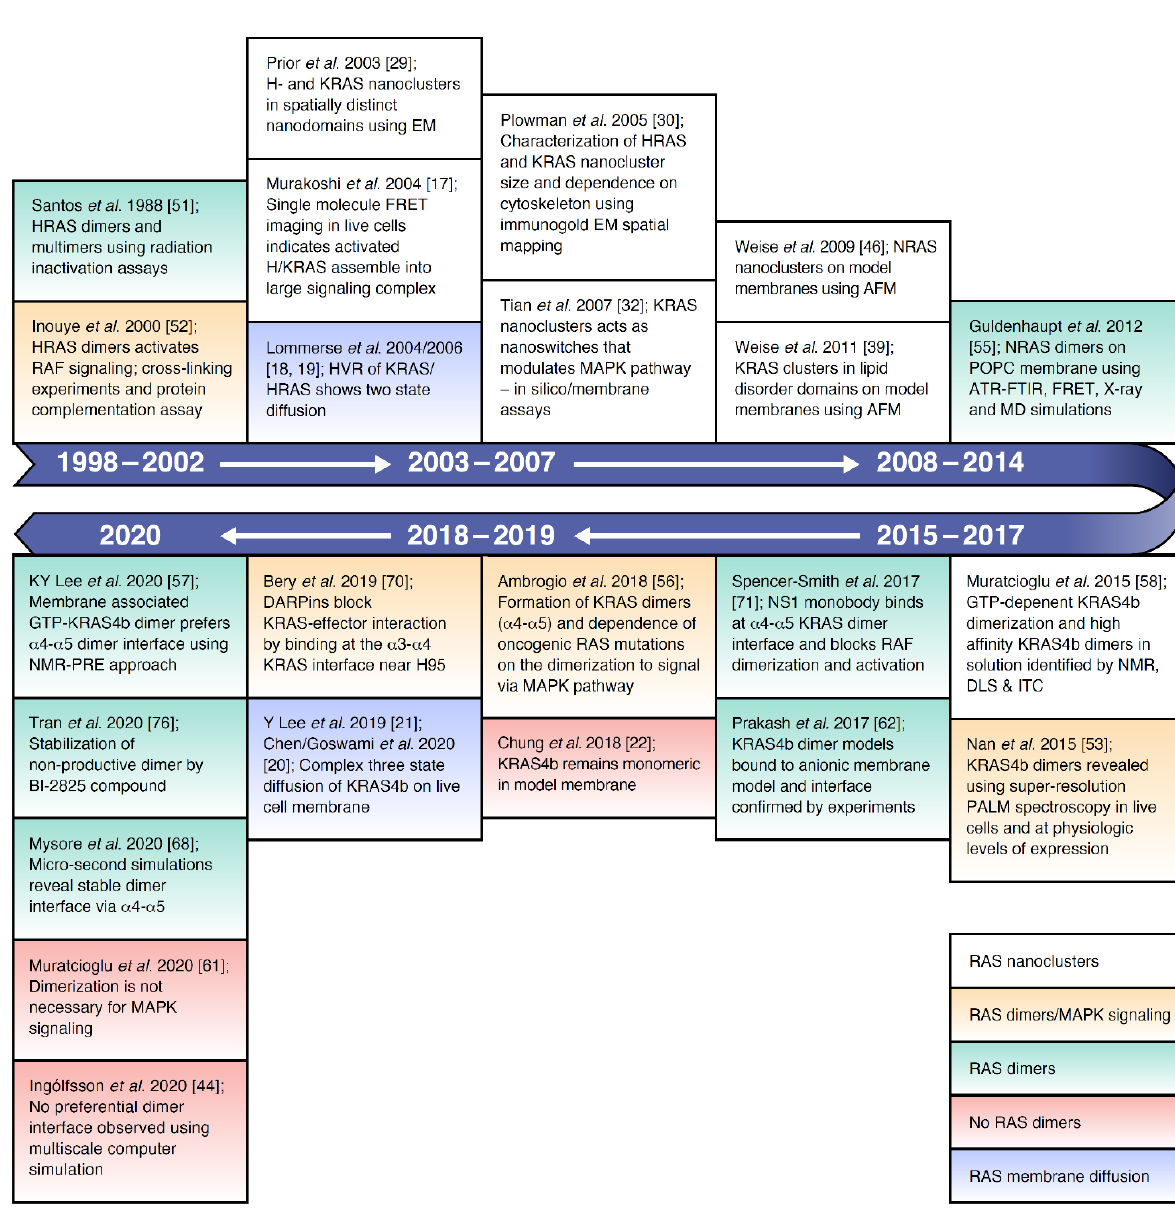
Figure 1. Literature timeline for RAS nanoclusters, dimerization, and membrane diffusion behavior.